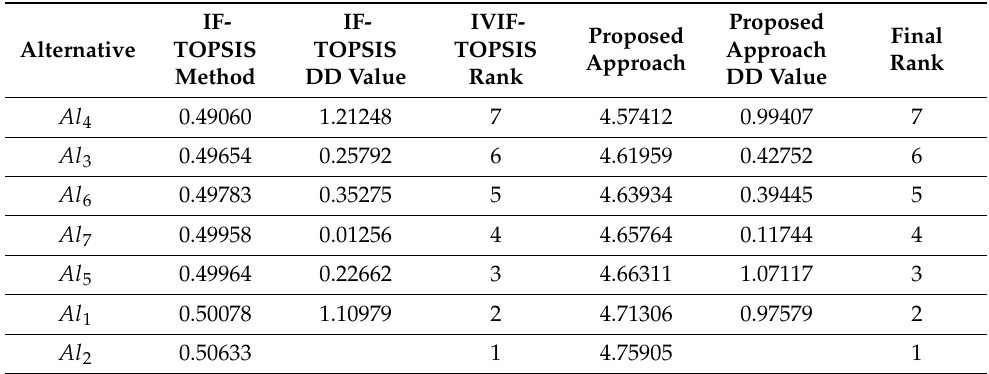
Table 17. Different degrees of the proposed approach and IF-TOPSIS